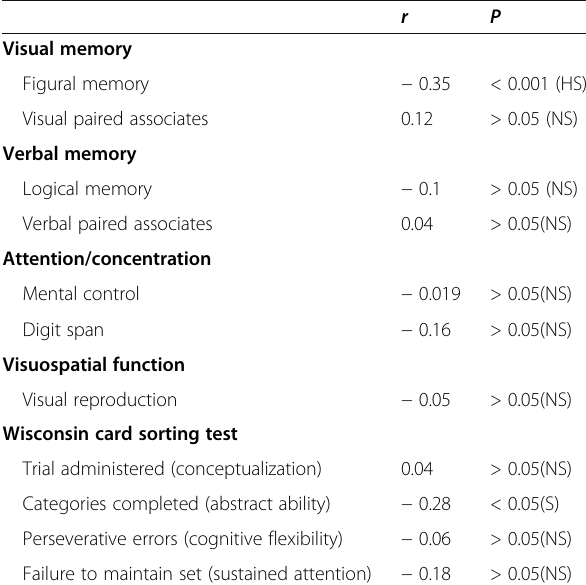
Table 6 Correlation between age at onset of MDD and cognitive and executive